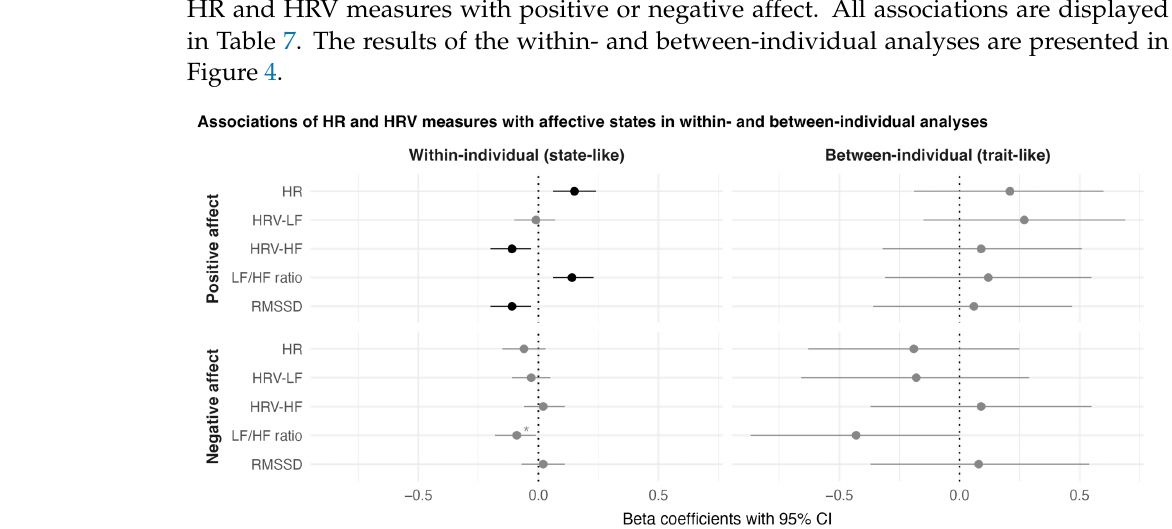
Figure 4. Results of within-individual and between-individual analyses of the associations between HR and HRV measures and affective states stratified for being in an upright body position and being inactive. HR, heart rate; HRV-LF, low-frequency power; HRV-HF, high-frequency power; LF/HF ratio, ratio of low- to high-frequency power; RMSSD, root-mean-square of successive differences; CI, confidence interval. The depicted confidence intervals have not been corrected for multiple comparisons. Interpretations concerning the significance of an association might, therefore, differ from the FDR-corrected p -values. Black coloured dots and Cis indicate associations that were significant after FDR correction. Asterisks (*) indicate associations that were significant before, but not after, FDR correction.